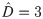
Macaque cerebral cortex positioning.The left panel shows the node positions determined by the physical distances of the ROI. The connectivity in the left panel consists of the observed and present connections in the data. The right panel shows the posterior expectations of node distances as determined by the latent space model, with optimal dimensionality D^=3. Note positions are approximated using multidimensional scaling, based on the distances on the cortex and the posterior expectation of distances in the latent space.